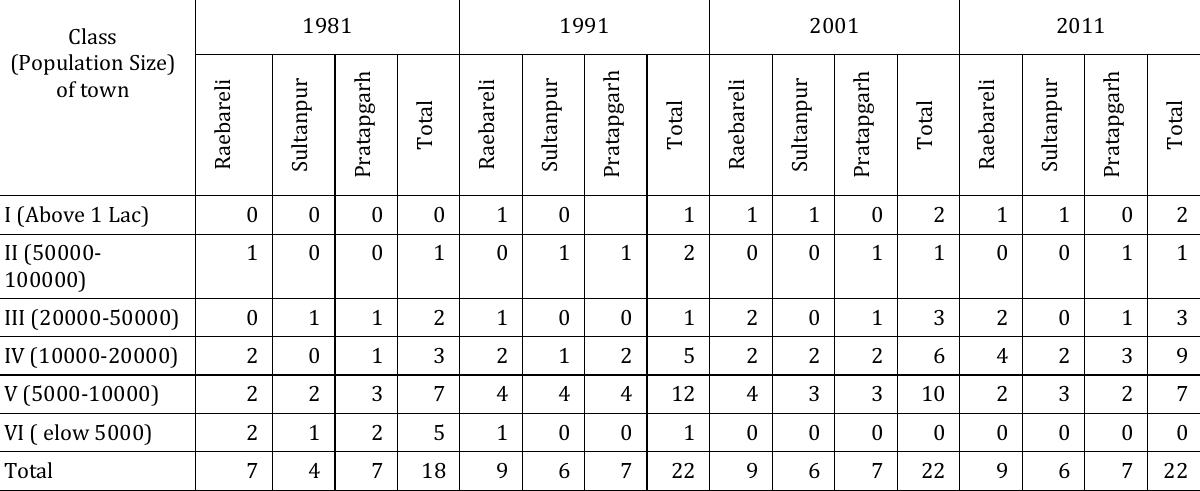
Table 1. Growth of towns in the study area according to size class (Source: computed, based on various